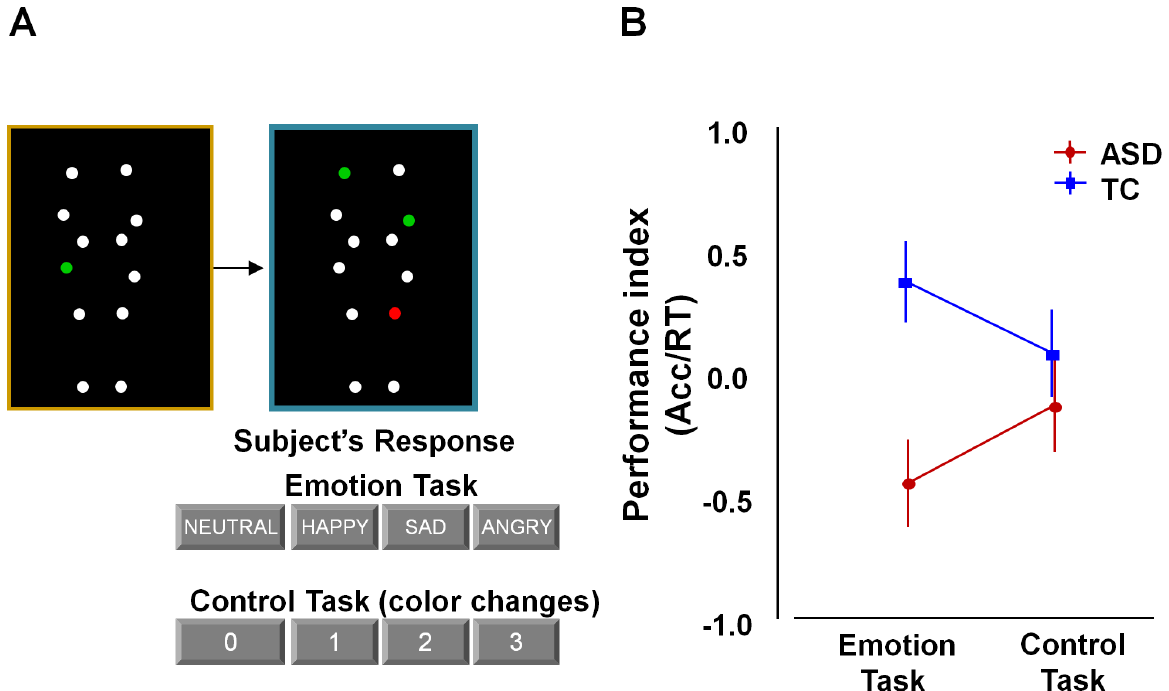
Fig 1. Behavioral performance on the bodily emotion recognition task. Participants determined the emotional state of point light displays (PLD) in which moving white dots reflected the main joints of the human body. (A) The emotional state of the blue-bordered PLD had to be indicated relative to the baseline yellow-bordered PLD (always showing a neutral emotional state). The same PLD-stimuli were presented in a four-choice control task matched for cognitive and motor demands. Here, one of the dots in the yellow-bordered PLD briefly changed color to either red or green. Subsequently, participants had to indicate the number of dots that changed into the same color in the blue-bordered PLD (2 in this example). (B) Performance was higher in the TC-group compared to the ASD-group on the emotion recognition task, but not on the control